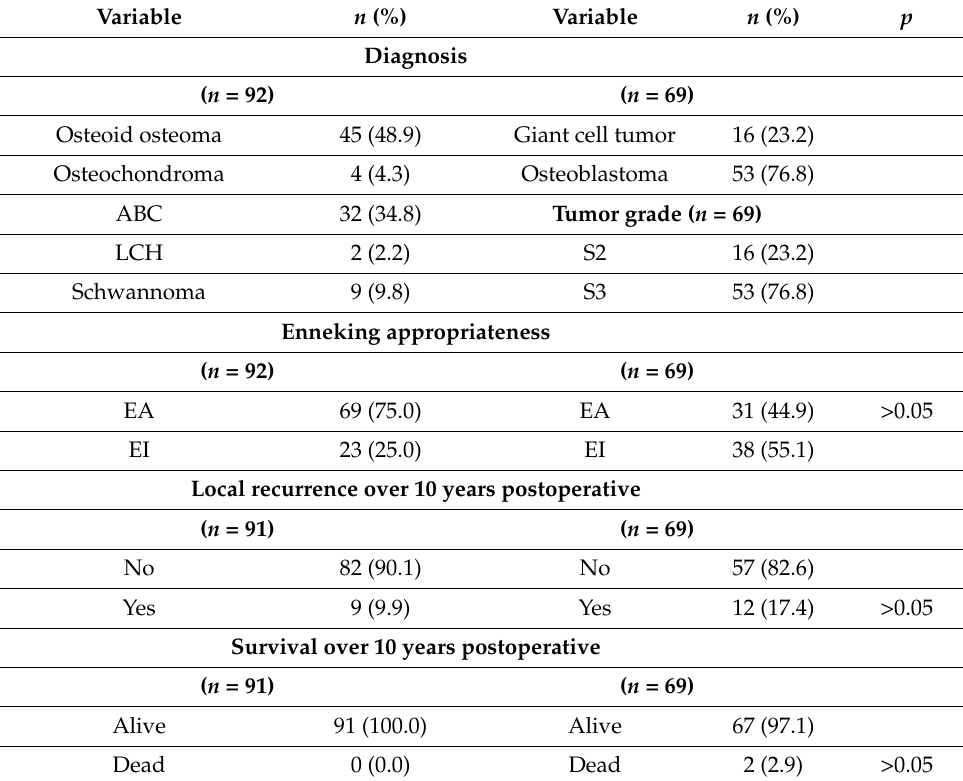
Table 4. Comparison of patient characteristics between less aggressive entities (left side) and GCT/OBL patients (right